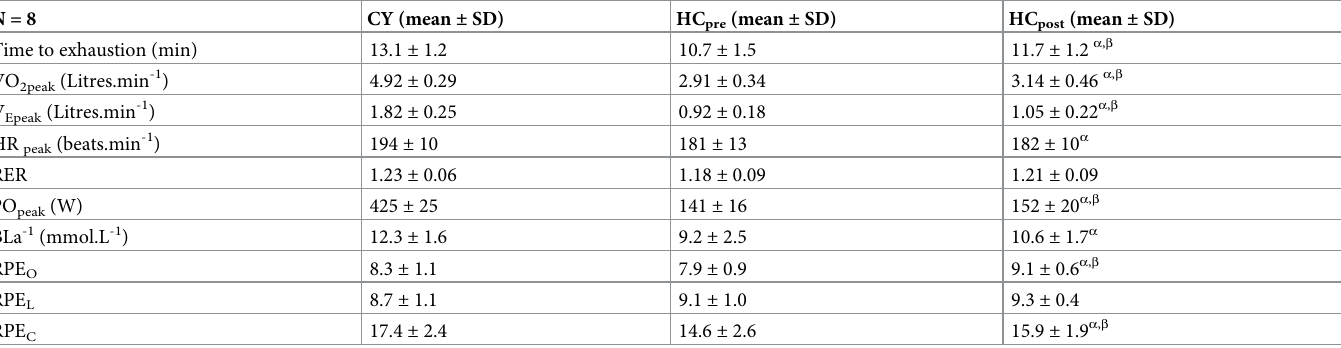
Table 1. Mean peak outcomes of incremental maximal cycle (CY), handcycle before (HC pre ) and after (HC post ) training. N = 8 CY (mean ± SD) HC pre (mean ± SD) HC post (mean ±